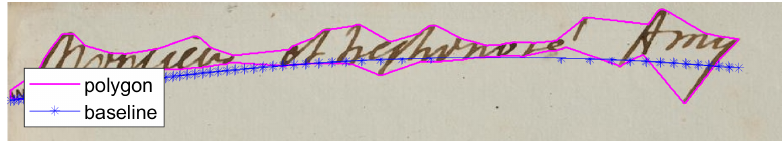
Figure 6. Baseline extraction from bounding